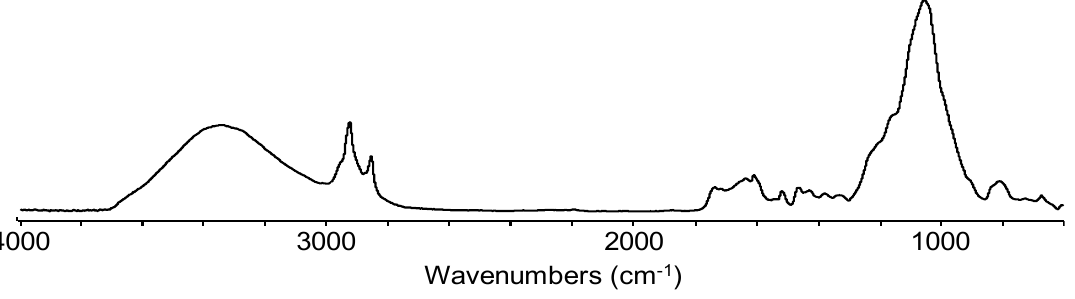
Figure 4. Fourier-transform infrared spectroscopy (FTIR) spectrum of rice hulls.